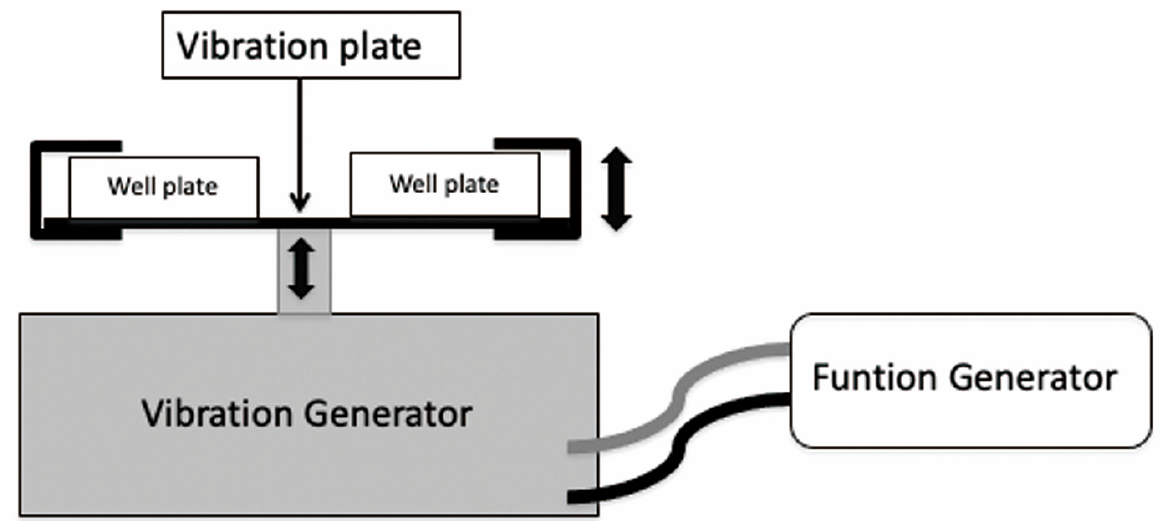
Figure 1. The vibration system used in the